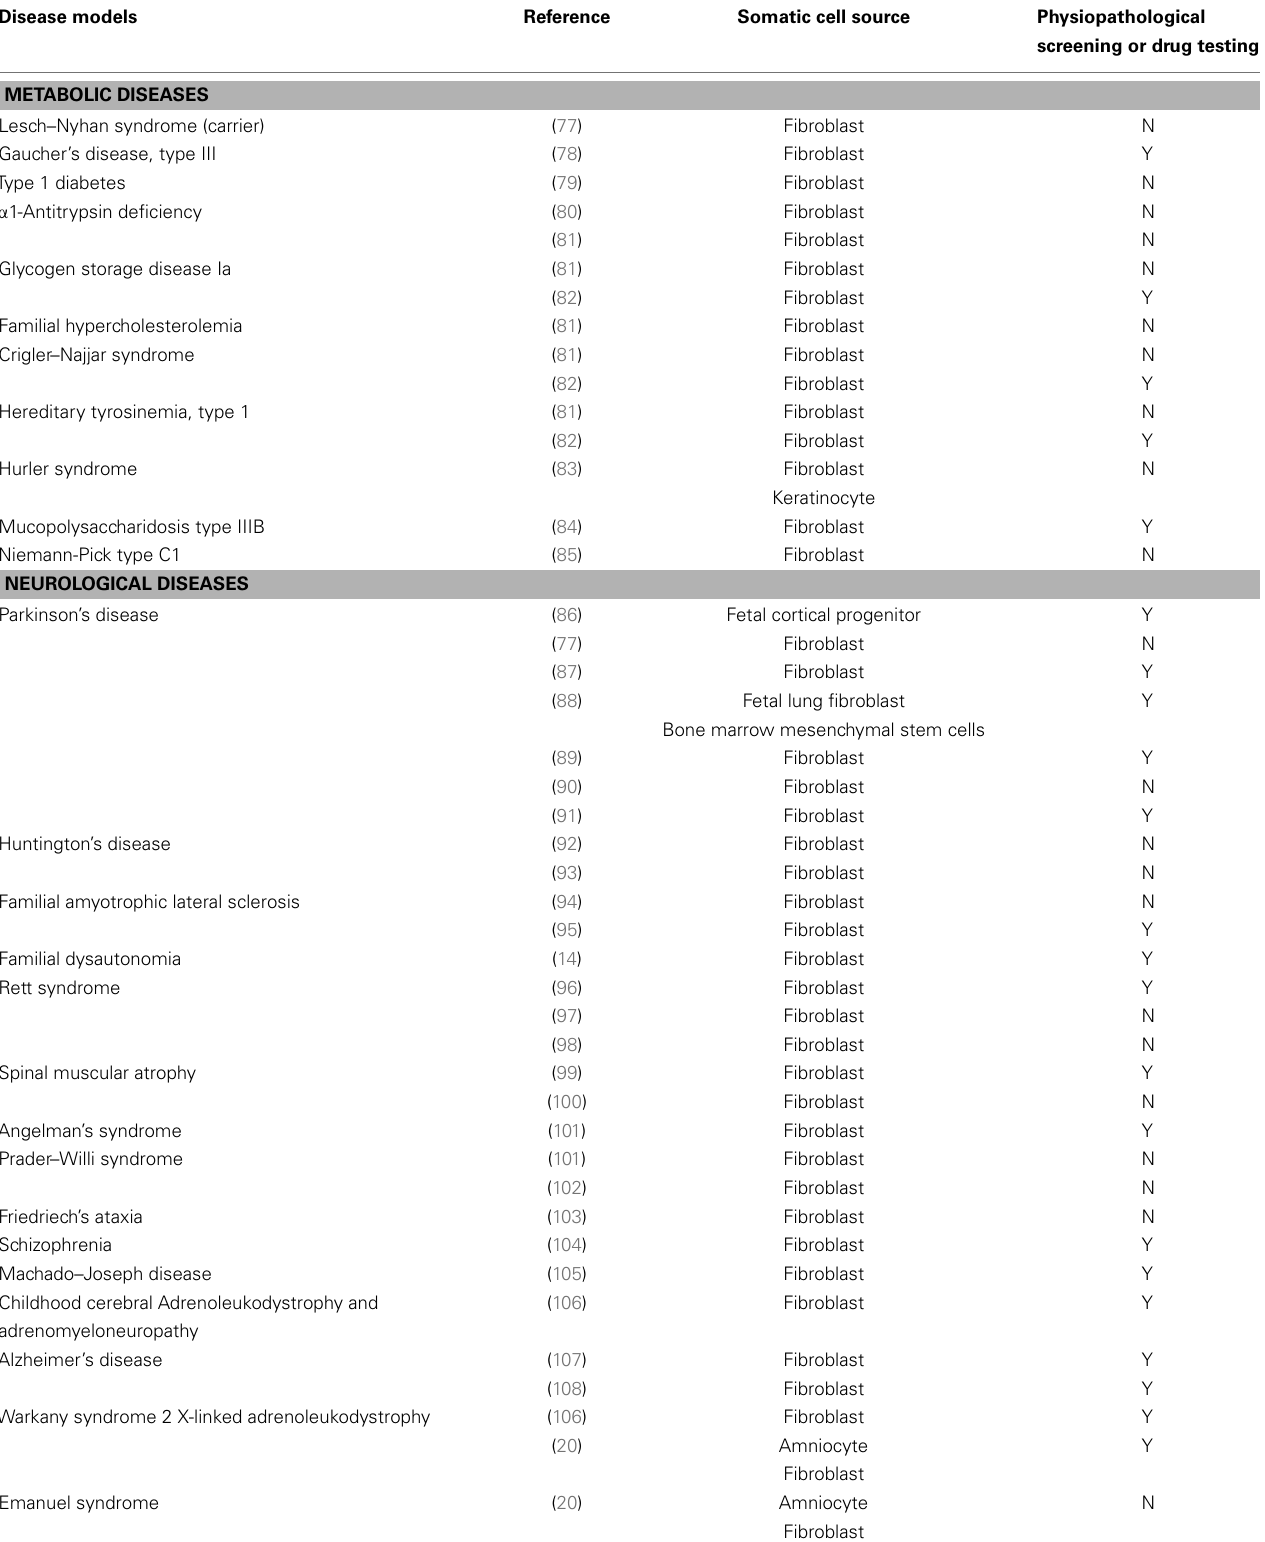
TableA1 | Diseases modeled with fully differentiated disease-specific